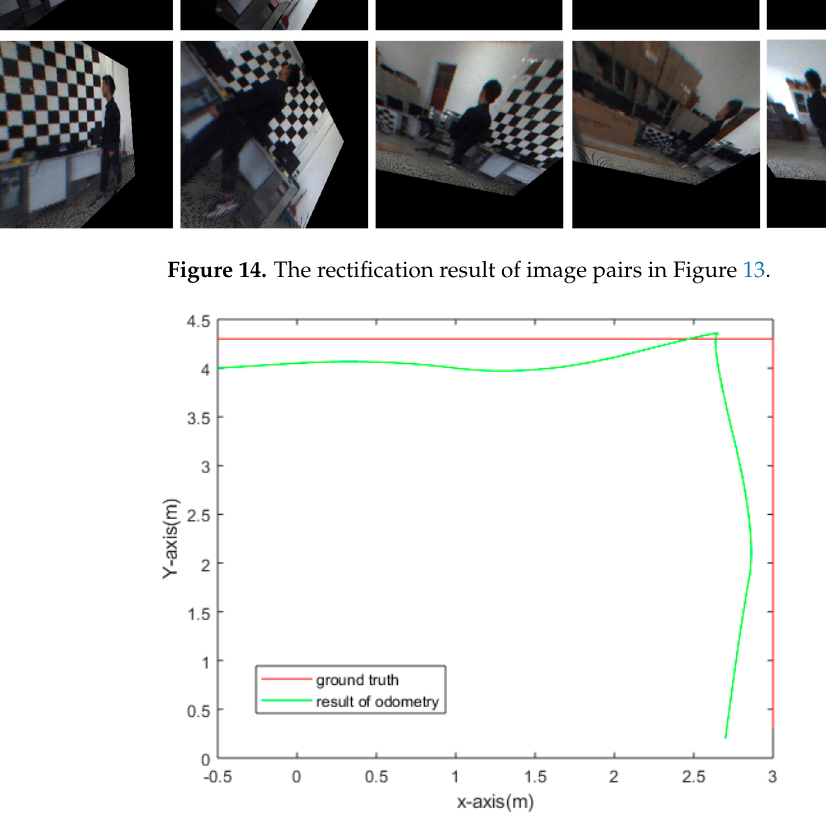
Figure 15. The comparison of odometry results and ground truth.